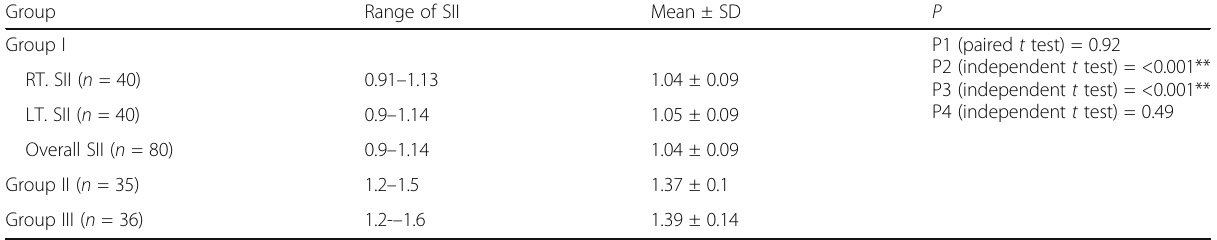
Table 3 Range, mean, and SD of SII in the normal, ankylosing spondylitis, and metastatic cases Group